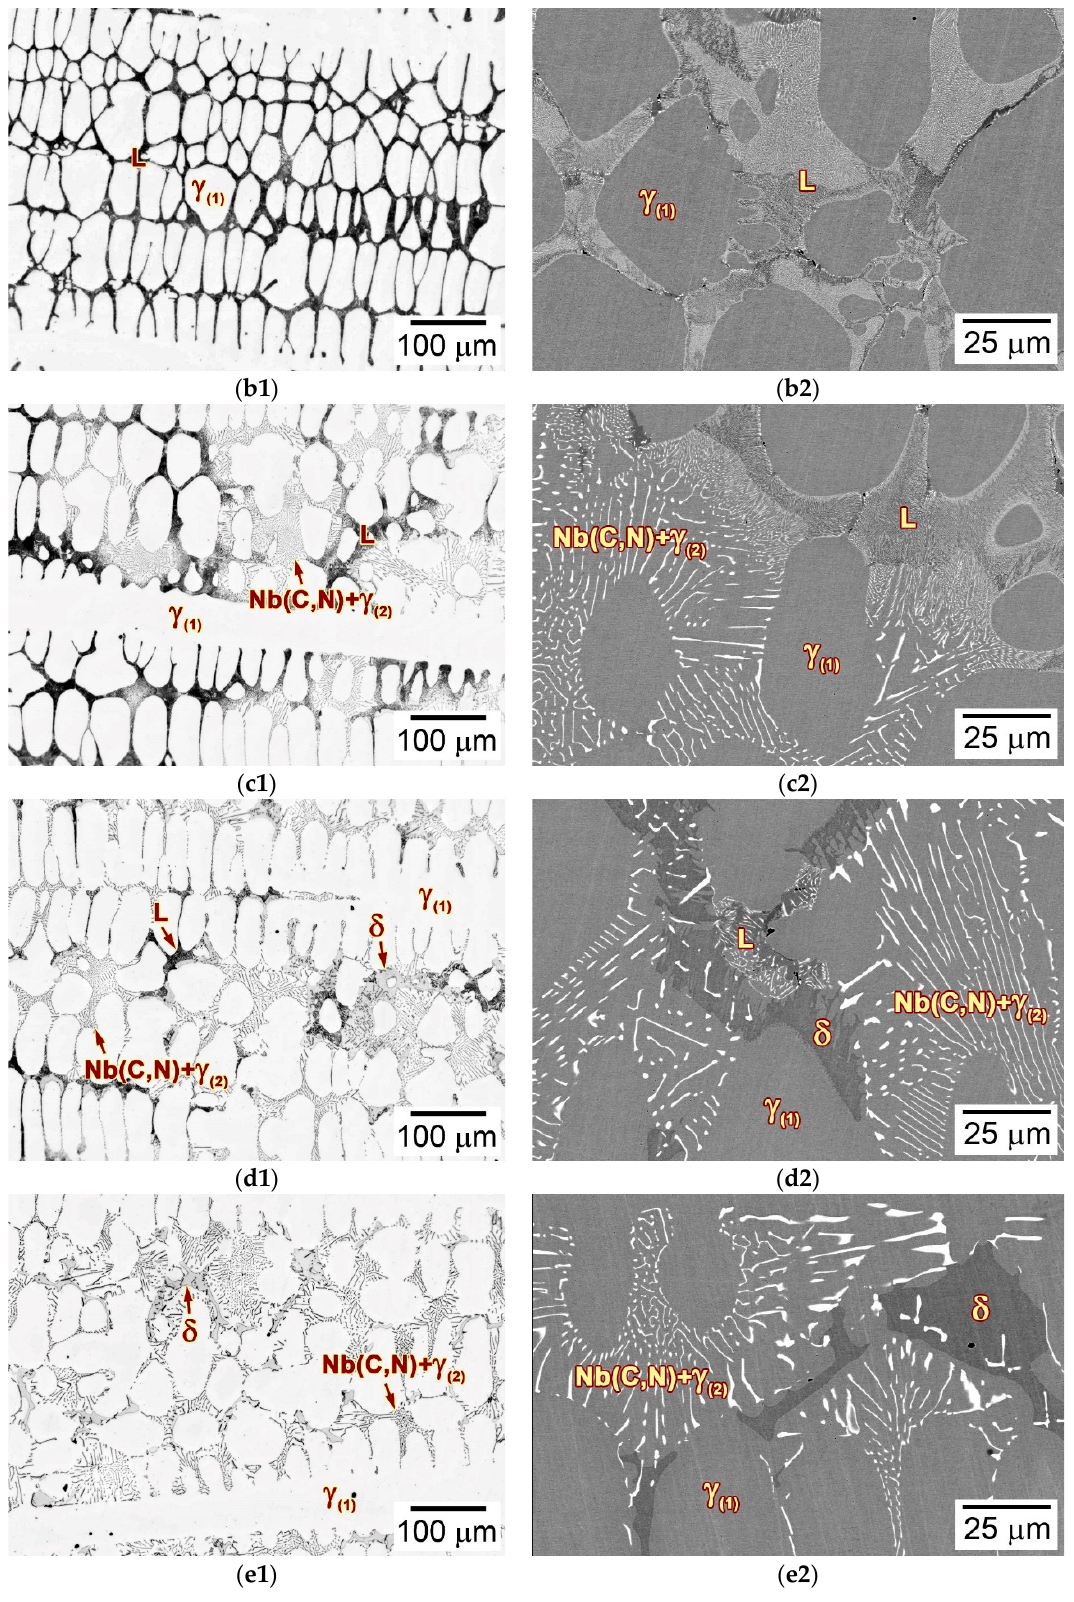
Figure 9. Optical and enlarged SEM-BSE images showing the typical microstructure of each solidification stage marked by red circles in Figure 6b under the withdraw rate of 50 µ m/s: ( a1 , a2 )